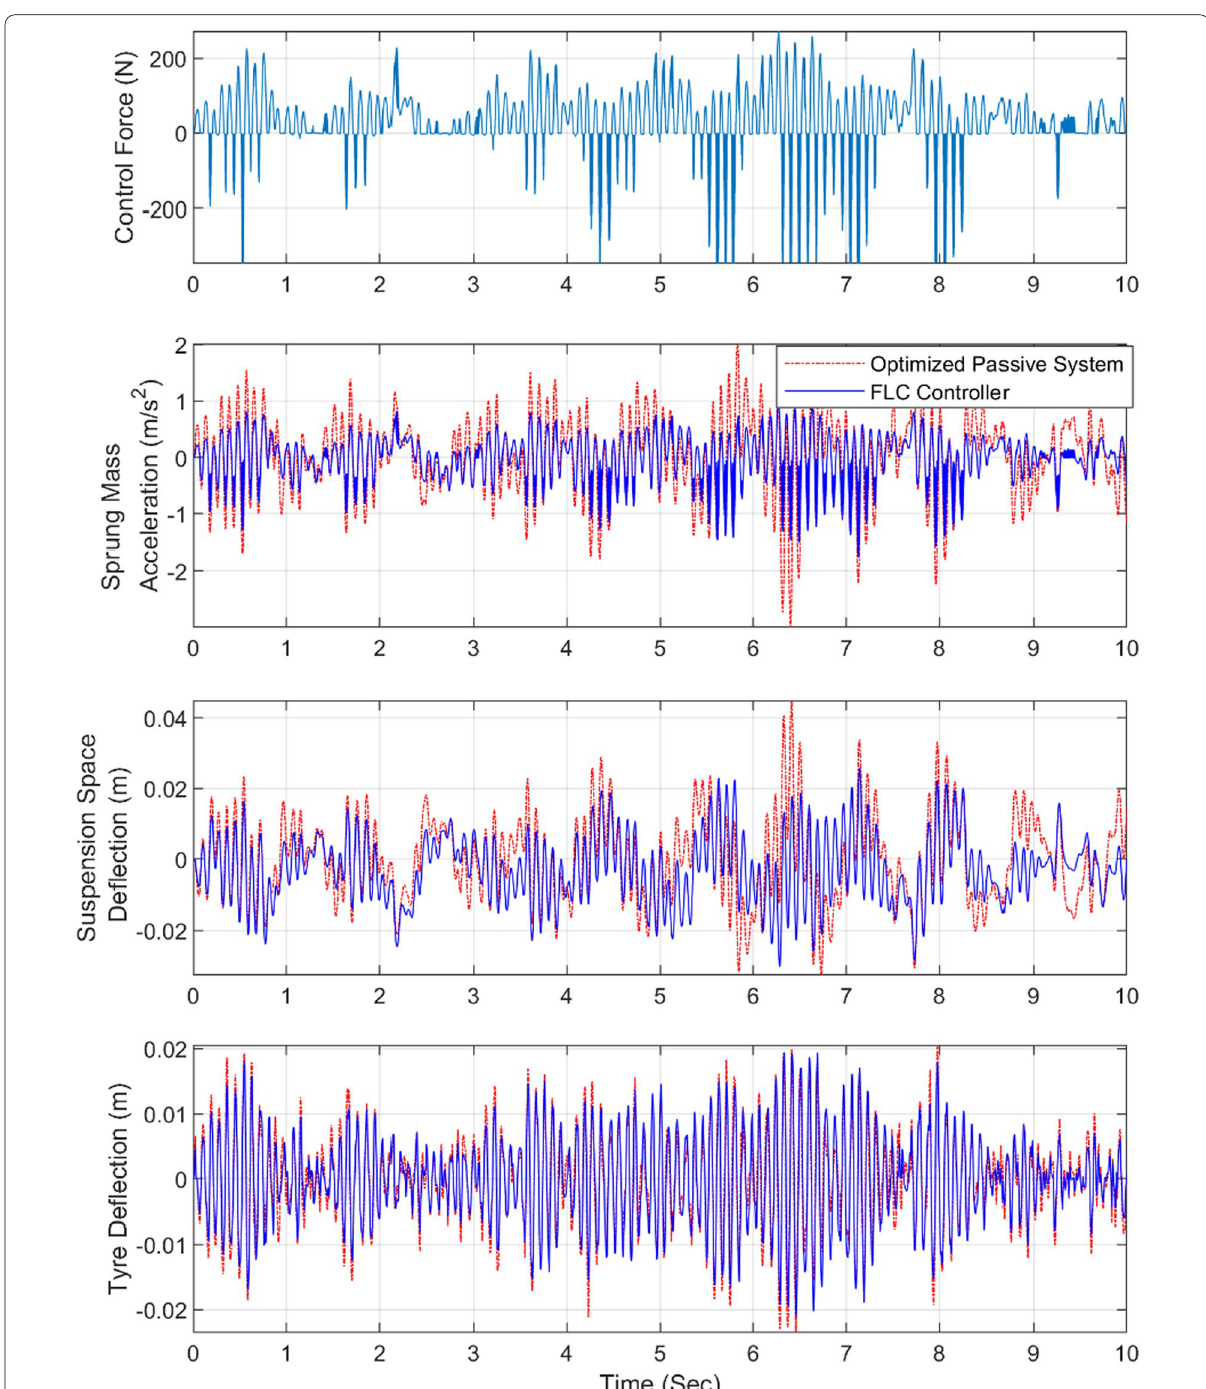
Fig. 8 Time domain results—optimized passive and initial FLC suspension